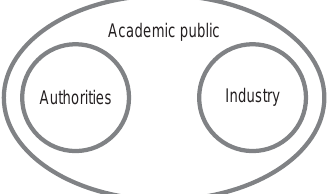
Fig. 1. The ‘triple helix’ model with one dominating element